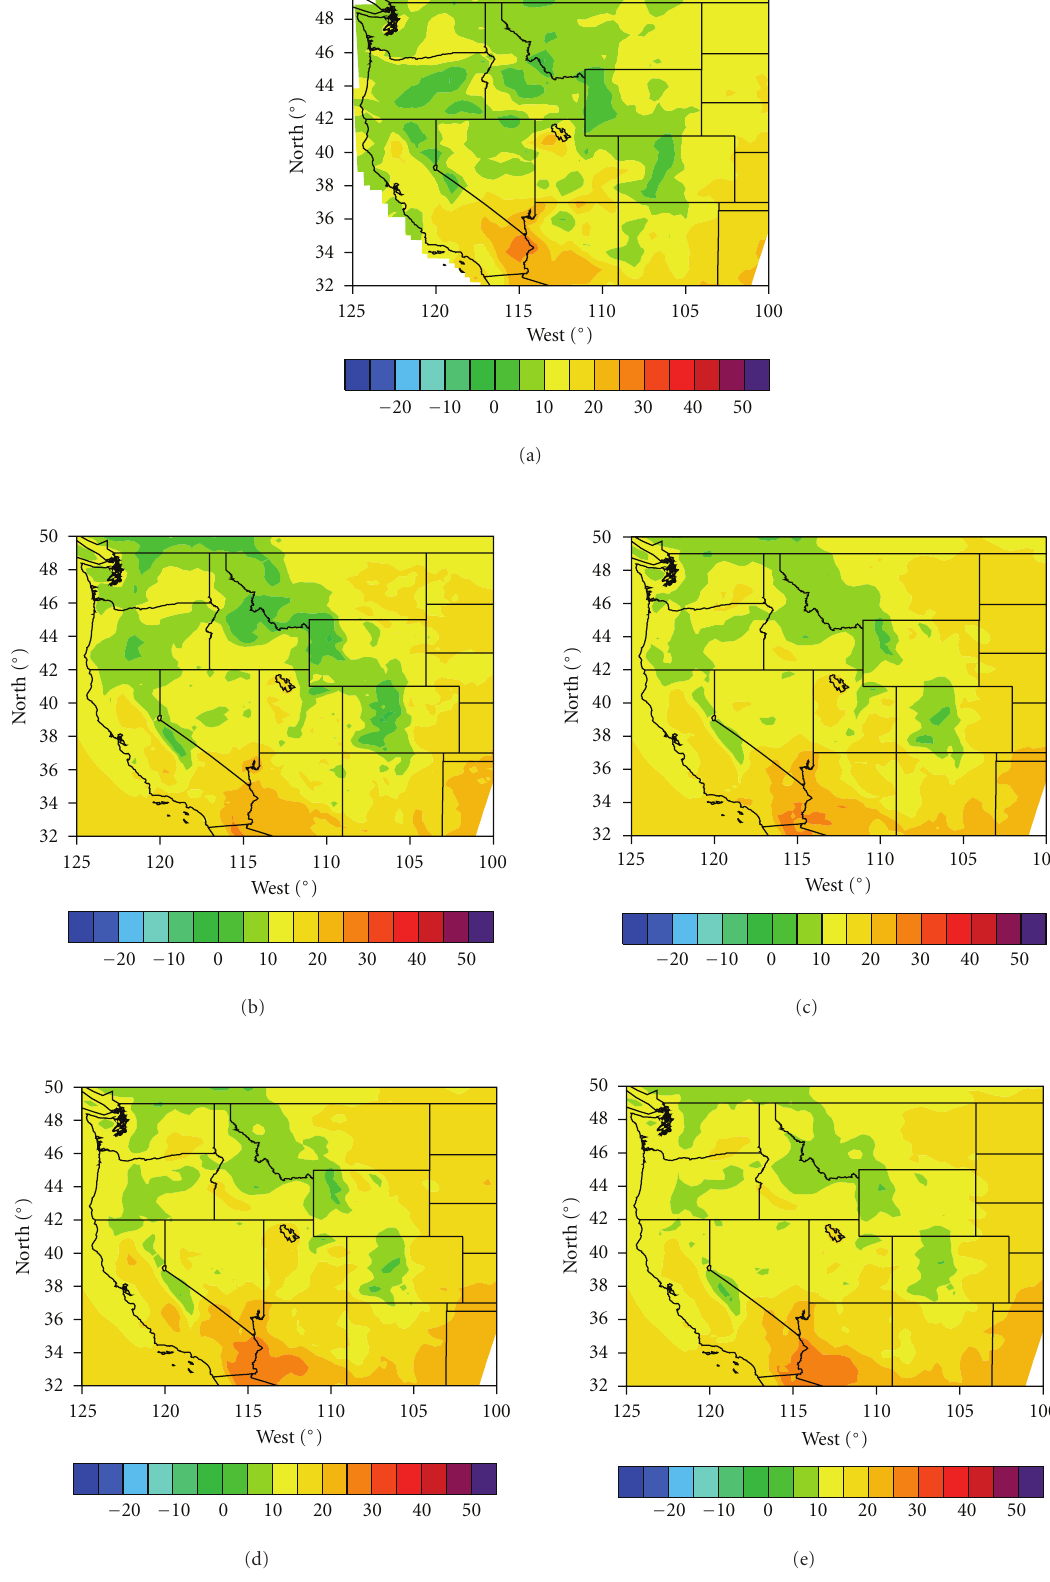
Figure 7: The geographic distribution of observed and WRF-simulated summer (June, July, and August) daily minimum temperature (Unit: ◦ C). (a) Observations; (b) CLM3; (c) Noah; (d) RUC; (e)